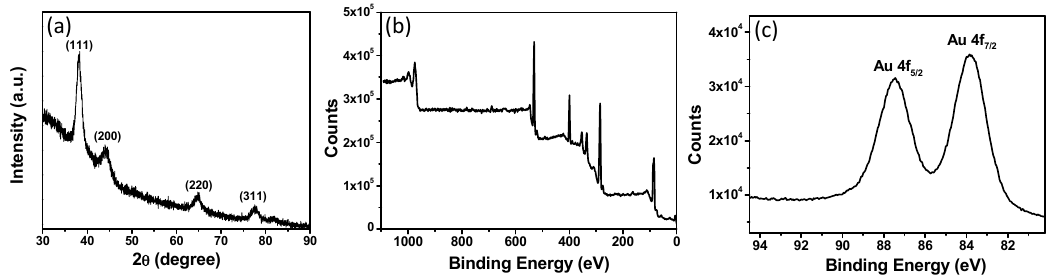
Figure 5. ( a ) XRD pattern of wool powder with AuNPs; ( b , c ) XPS spectra of wool powders after heat treatment.